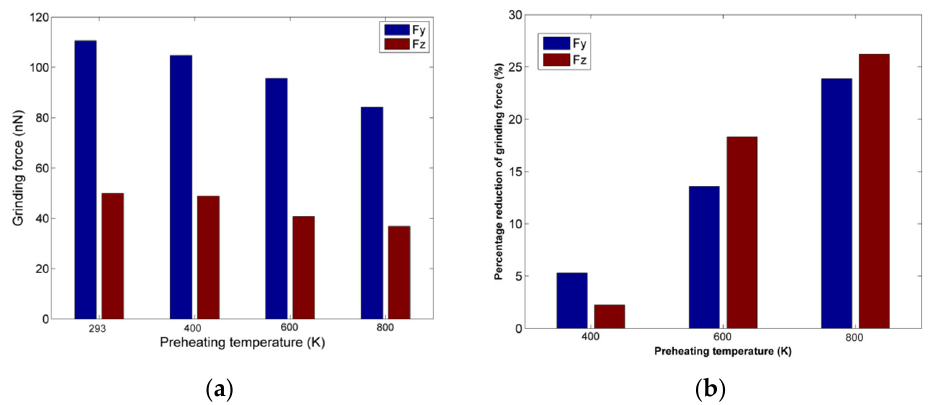
Figure 3. ( a ) Grinding forces values for different preheating temperatures; ( b ) percentage of grind- ing forces reduction at different preheating temperatures. forces reduction at different preheating